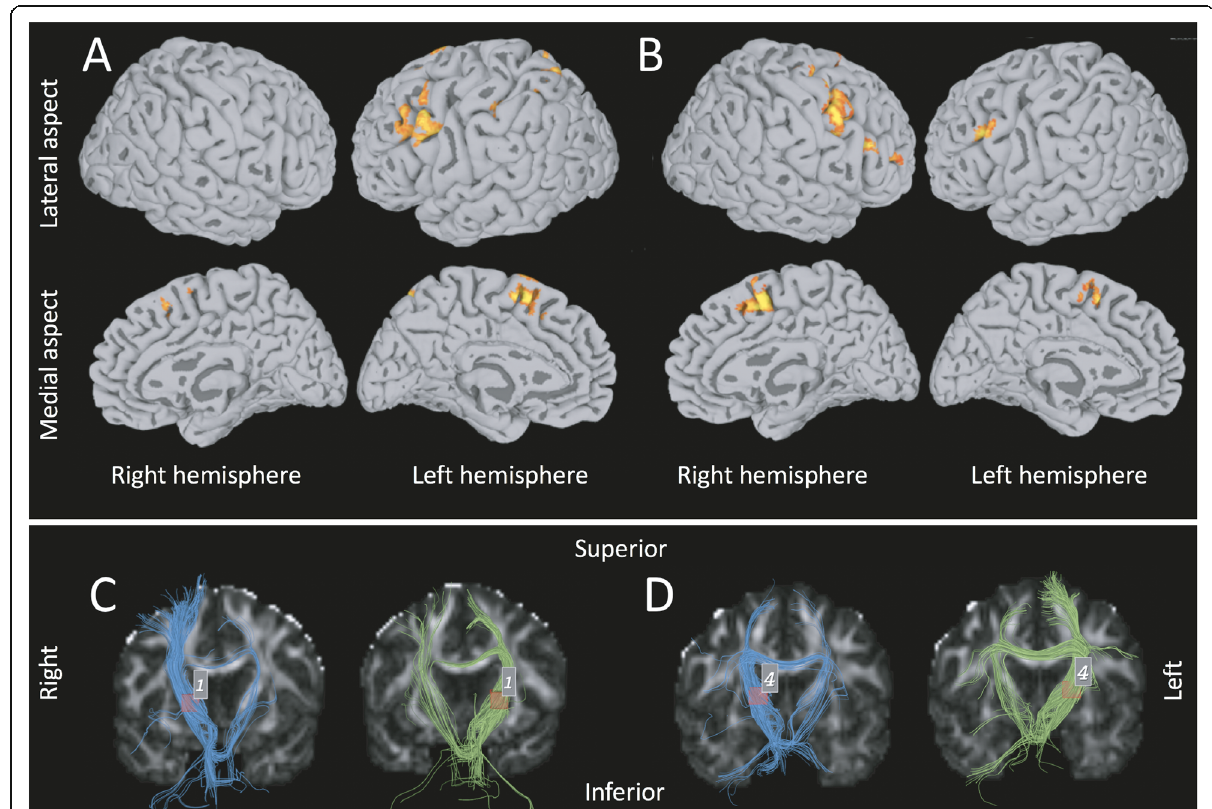
Fig. 2 MRI Brain imaging individual 1. fMRI activations overlaid on the semi-inflated FreeSurfer cortical surface for individual 1 ( a ) and control ( b ) in response to the silent word generation task. DTI tractography of corticospinal tracts of individual 1 ( c ) and the matched control ( d ). Right hemisphere tracts in blue, left hemisphere tracts in green. Volume of interest in